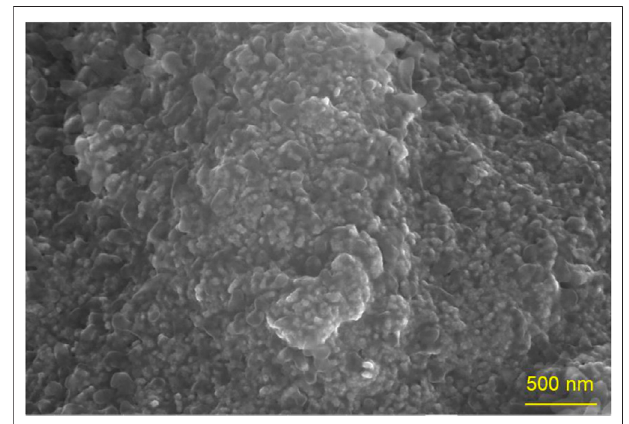
FIGURE 2 | SEM images of synthesized